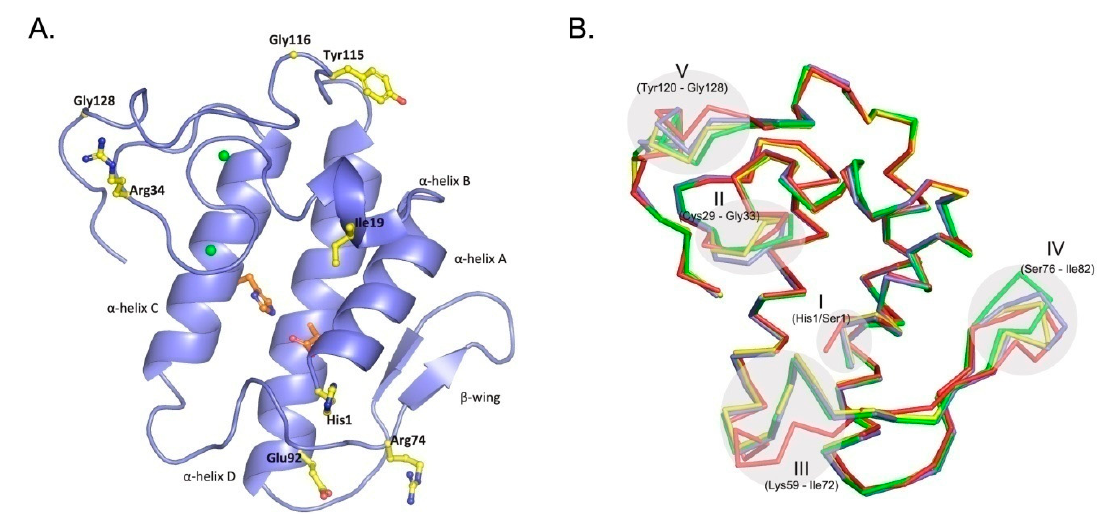
Figure 1. Overall three-dimensional structure of the CBd isoform. ( A ) Crystal structure of CBd, with distinguishing residues at positions 1, 19, 34, 74, 92, 115, 116, and 128 shown in yellow stick representation. The α -helices A–D and the β -wing are labeled and the His48 / Asp99 pair of the catalytic site is shown in red. ( B ) Superposition of the α -carbon backbones of the four natural CB isoforms which have been crystallographically resolved: CBa 2 (pdb 2QOG, polypeptide chain A) in red, CBb (pdb 3R0L, polypeptide chain D) in green, CBc (pdb 2QOG, polypeptide chain B) in yellow and CBd (this study, pdb 6TMY) in blue. Five conformationally variable or flexible regions are indicated (see text). Table 1. Crystallographic data and refinement statistics .